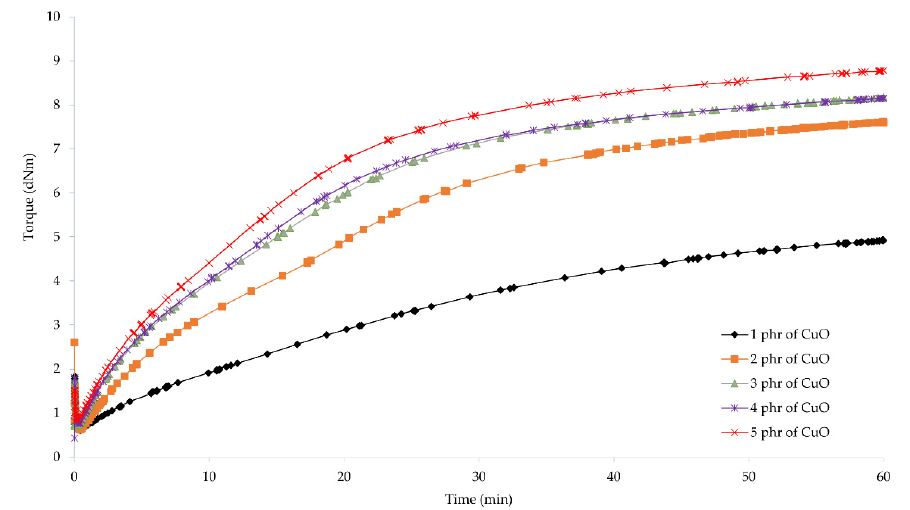
Figure 2. Vulcametric kinetics of chloroprene rubber cross-linked with copper(II) oxide (1–5 phr of